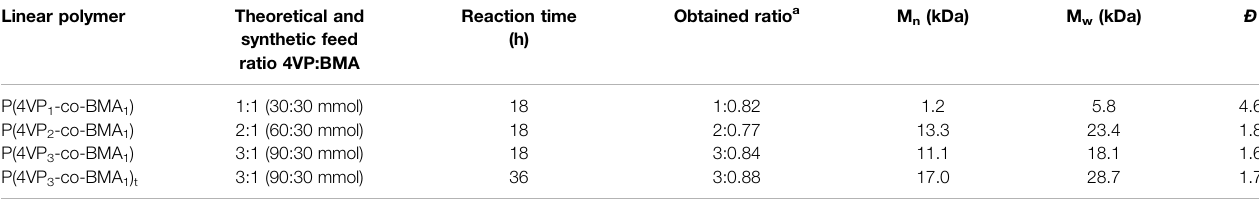
TABLE 2 | Linear polymers: theoretical/synthetic feed ratios of monomers used, obtained ratios, and characterization data. Linear polymer Theoretical and synthetic feed